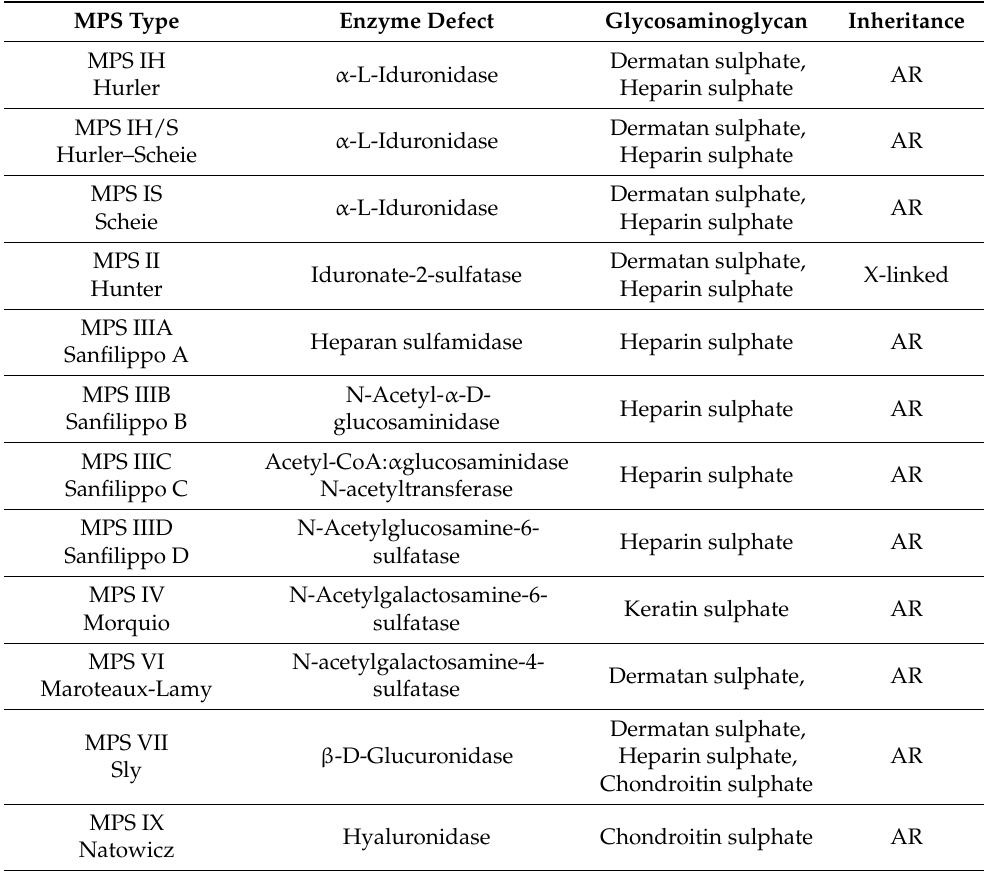
Table 2. Enzyme defect, glycosaminoglycan deposited and inheritance pattern of the mucopolysac- charidoses. Data from Ashworth et al.